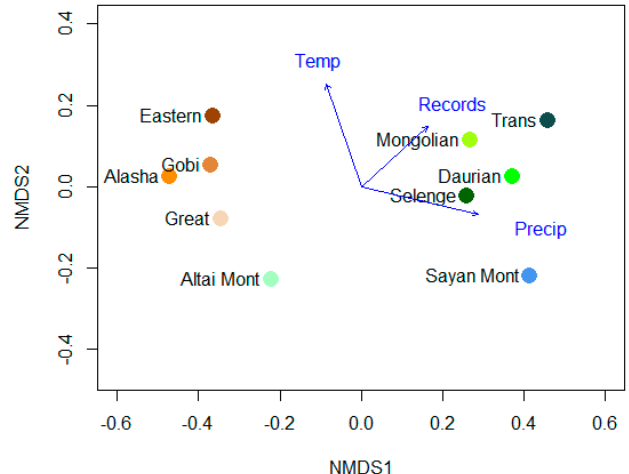
Figure 6. Non-metric multidimensional scaling (NMDS) ordination of 10 ecoregions of Mongolia according to their dissimilarity in geometrid moth species assemblage (zero-adjusted Bray-Curtis dissimilarity index for presence-absence data; stress 0.05). Significant variables are drawn in blue arrows. Temp: Maximum temperature of warmest month, Precip: Precipitation, Records: Number of records of geometrid moths. Colors refer to the map in Figure 1. Ecoregion abbreviations as in Figure 4.